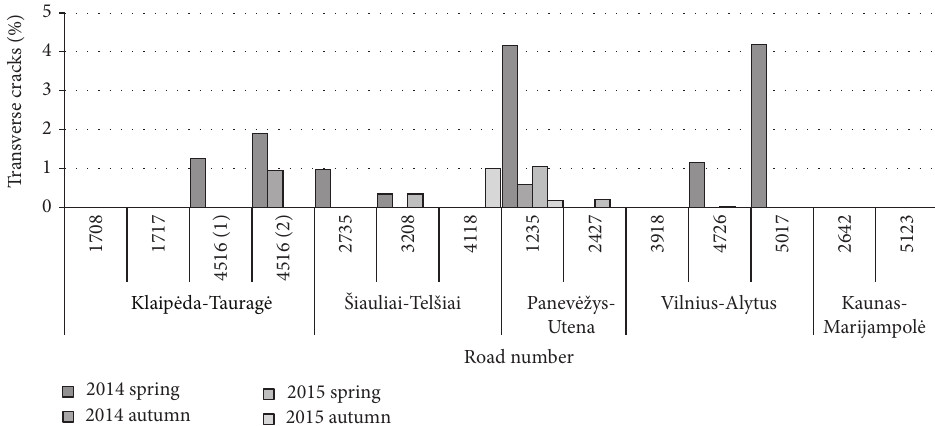
Figure 12: Transverse cracks on roads sections covered with double Otta Seal.